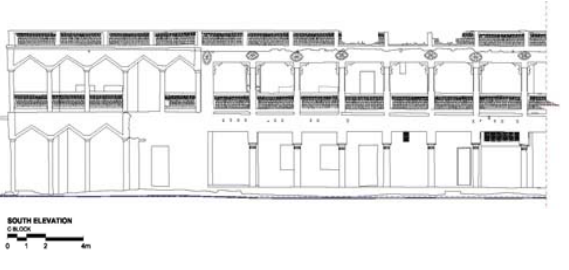
Figure 5. A Final south elevation of private block produced in